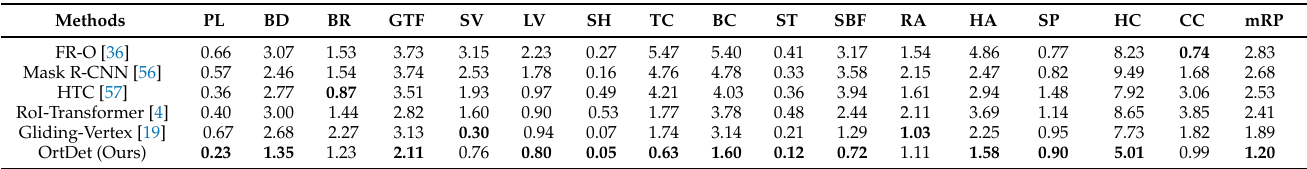
Table 5. Mean rotation precision (%) of the different methods for the DOTA-v1.5 dataset.